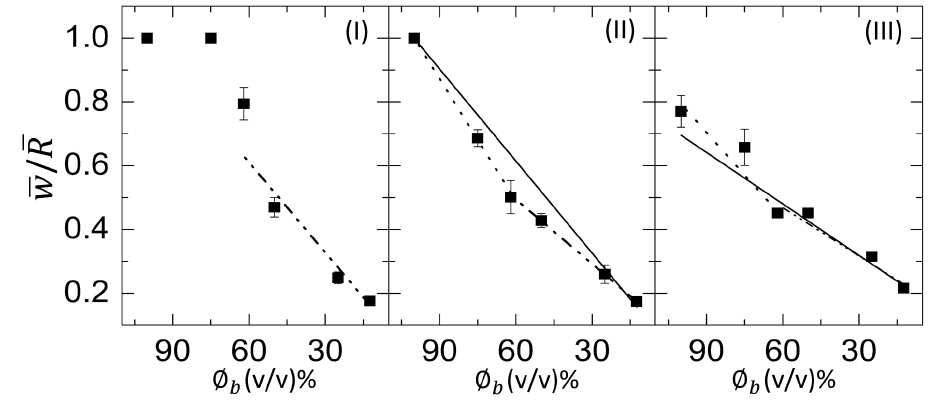
Figure 11. Concentration dependence of the normalized ring width ( w / R ) of the whole human blood film at different substrate temperatures (T) at ( I ) 45 ◦ C, ( II ) 35 ◦ C, and ( III ) 25 ◦ C. The solid line depicts the linear fit over the whole range from 100 to 12.5% ( v / v ). The dotted and dash-dotted lines show the linear fit from 100 to 62%, and 62 to 12.5% ( v / v ), respectively. The dashed line at T = 45 ◦ C is a line drawn to guide our eyes.